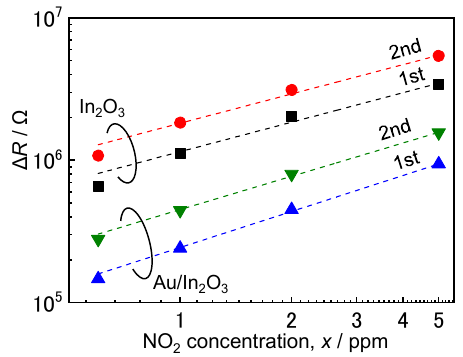
Figure 5. NO 2 concentration dependence of resistance of the In 2 O 3 and Au/In 2 O 3 sensors in wet air (70%RH at 25 °C) at 100 °C.